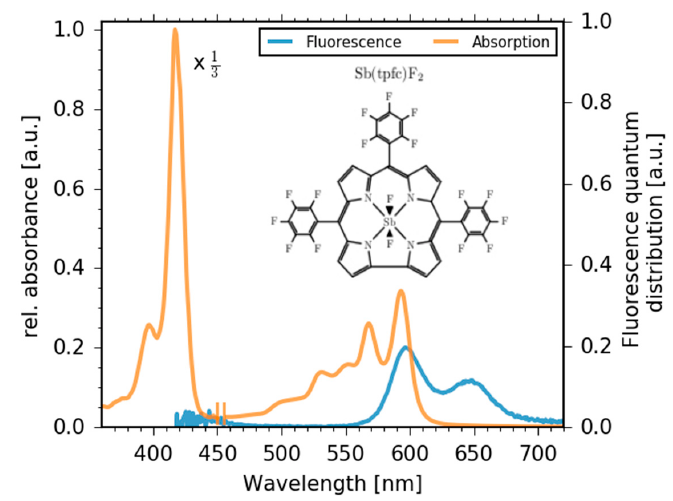
Figure 1. Steady-state absorption (orange line) and stationary fluorescence (blue line) of 5,10,15-tris- pentafluorophenyl-corrolato-antimony(V)- trans -difluoride (Sb-tpfc-F 2 ). Inset: Schematic of Sb-tpfc-F 2 . Note, the short wavelength part of the absorption spectrum up to 450 nm is scaled-down by a factor of 3.